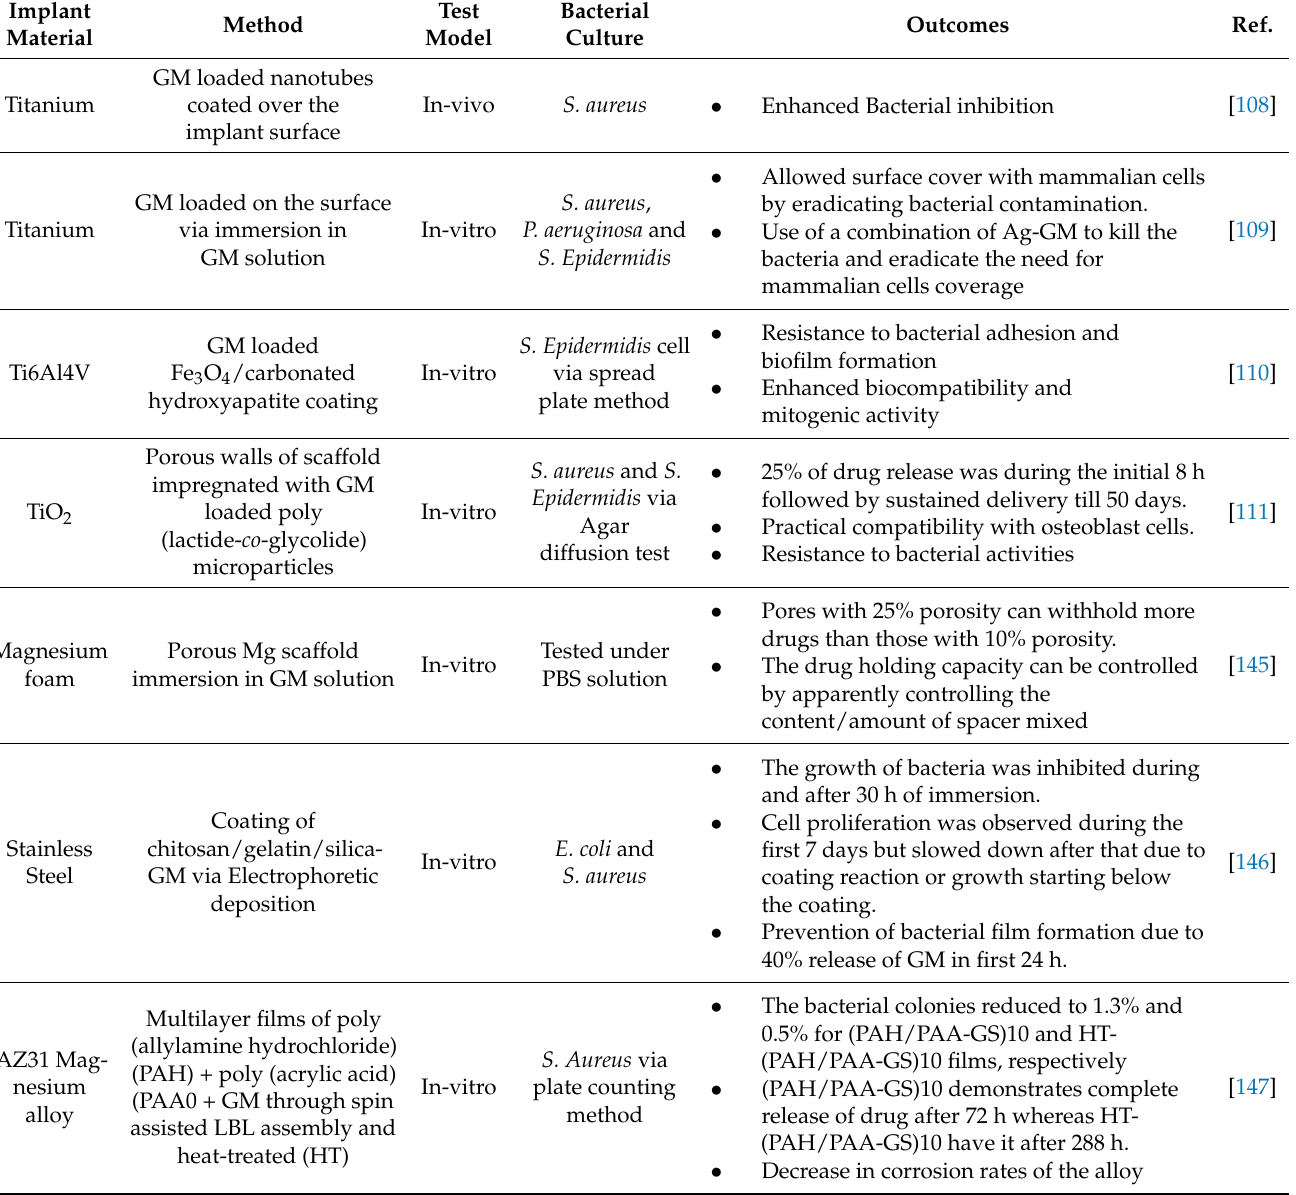
Table 2. In vivo and in vitro studies of GM-eluting metallic implants for reducing the bacterial activities in implantation